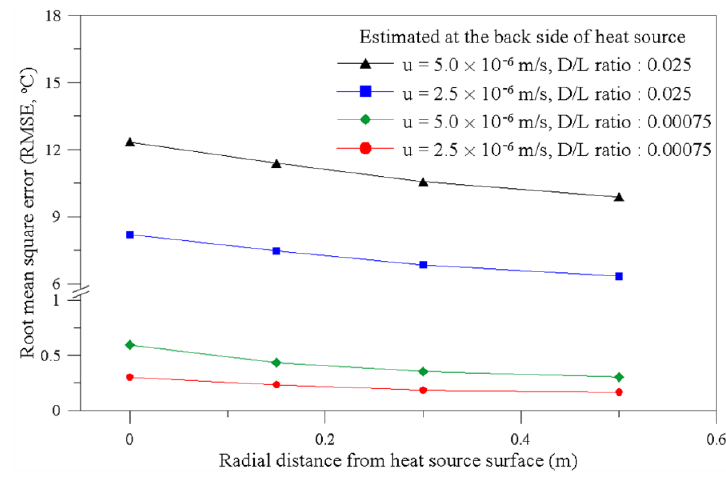
Figure 15. RMSE of numerical analysis between permeable and impermeable borehole condition at the back side of heat source.